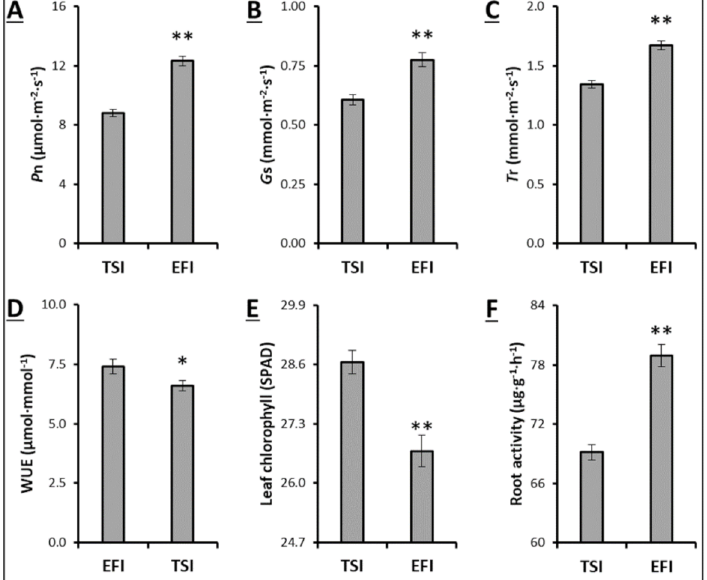
Figure 3. Effect of top sprinkle (TSI) and ebb-and-flow (EFI) irrigation on physiological at- tributes of tomato seedlings. Vertical bars indicate means ± SE ( n = 3, 10 plants per replicate). The * and ** represent significance at p ≤ 0.05 and p ≤ 0.01, respectively, according to Student’s t